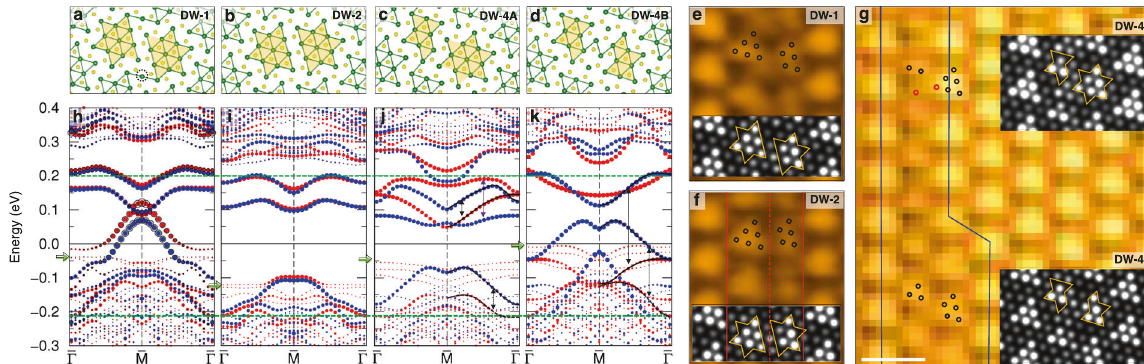
Fig. 3 Atomic and electronic structures of major domain walls. a - d Atomic structure: a DW-1, b DW-2, c DW-4A, and d DW-4B. The imperfect DS clusters are marked by the yellow shadows. e – g Experimental STM image (scale bar = 2 nm). The circles denote the top S atomic position in the atomic structure. Insets are the theoretical STM simulations. Simulated STM images are obtained by integrating charge density from − 1.2 to 0 eV (Fermi level) of each optimized structure. The images represent the charge density at a constant height of 2 Å away from the top S atom. Red lines in f denote the asymmetric double rows. Blue lines in g denote the domain edge of a single (DW-4A) and double rows (DW- 4B) domain walls. h – k Band structures. Red (Blue) circles denote the spin-majority (minority) states. The circle size is proportional to the localized states at the domain-wall region (shadow DS clusters). Black open circles in h are localized states at the linked atom marked by the dashed circle in a . Green arrows indicate the lower Hubbard states at domain region. Green dashed lines indicate the upper and lower Hubbard states of the CCDW phase for comparison. Purple arrows in k indicate the upper and lower Hubbard states of the domain edge. Black solid and dashed arrows in j and k are guides for the eyes for the spin-polarized bands.